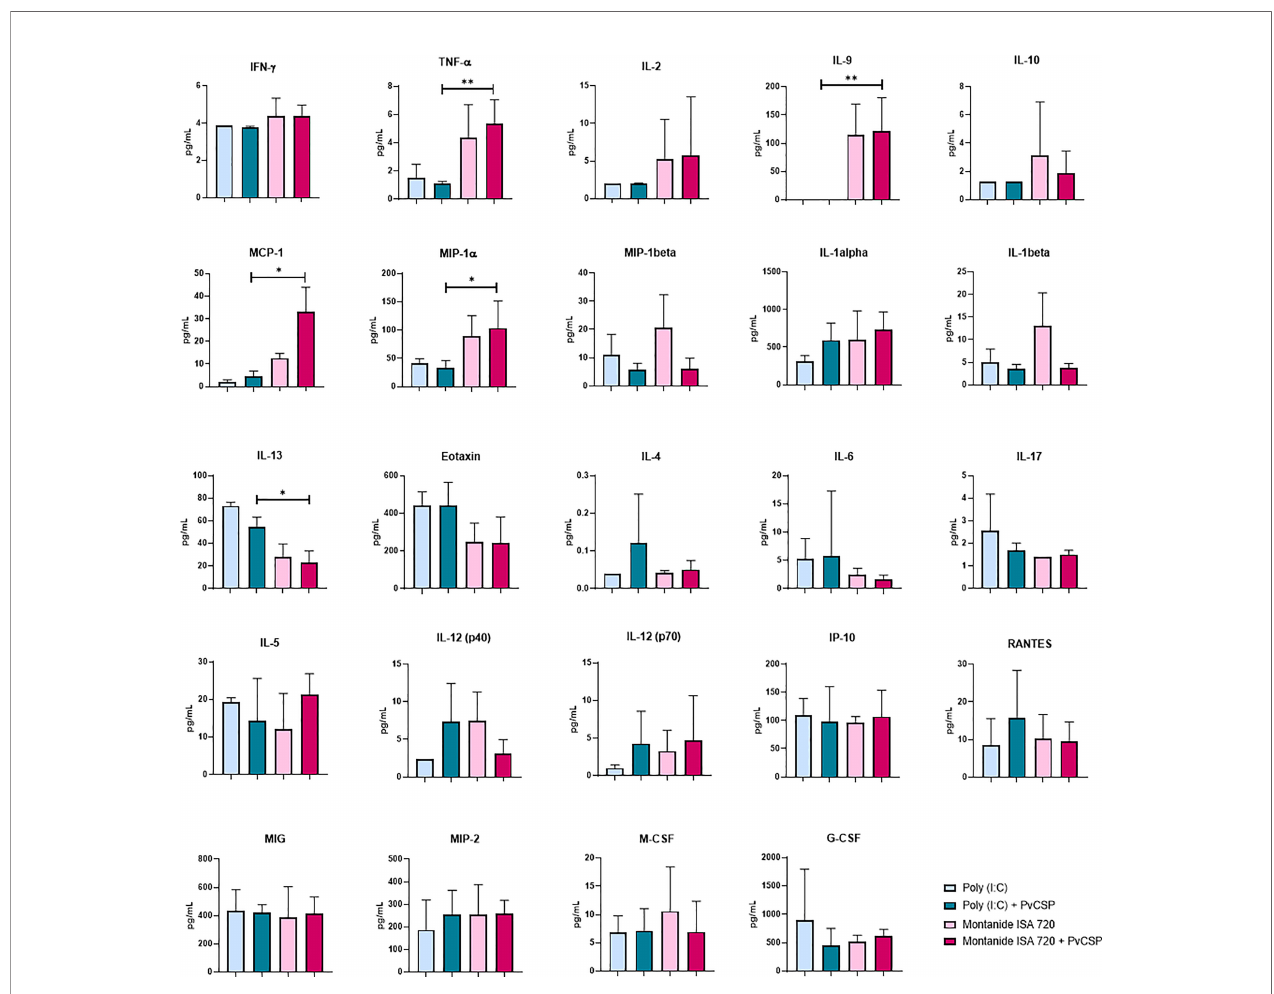
FIGURE 2 | Montanide ISA 720 favors serum in fl ammatory cytokines, while Poly (I:C) elicits a balanced pro fi le. The serum levels of cytokines were measured in mice sera obtained 14 days after the last immunization, by Luminex using the Milliplex MAP Mouse Cytokine/Chemokine Magnetic Bead Panel - Premixed 32 Plex. Sera samples were measured in triplicates; only the cytokines with the highest expression are depicted. Asterisks denote statistical differences; *p < 0.05; **p <